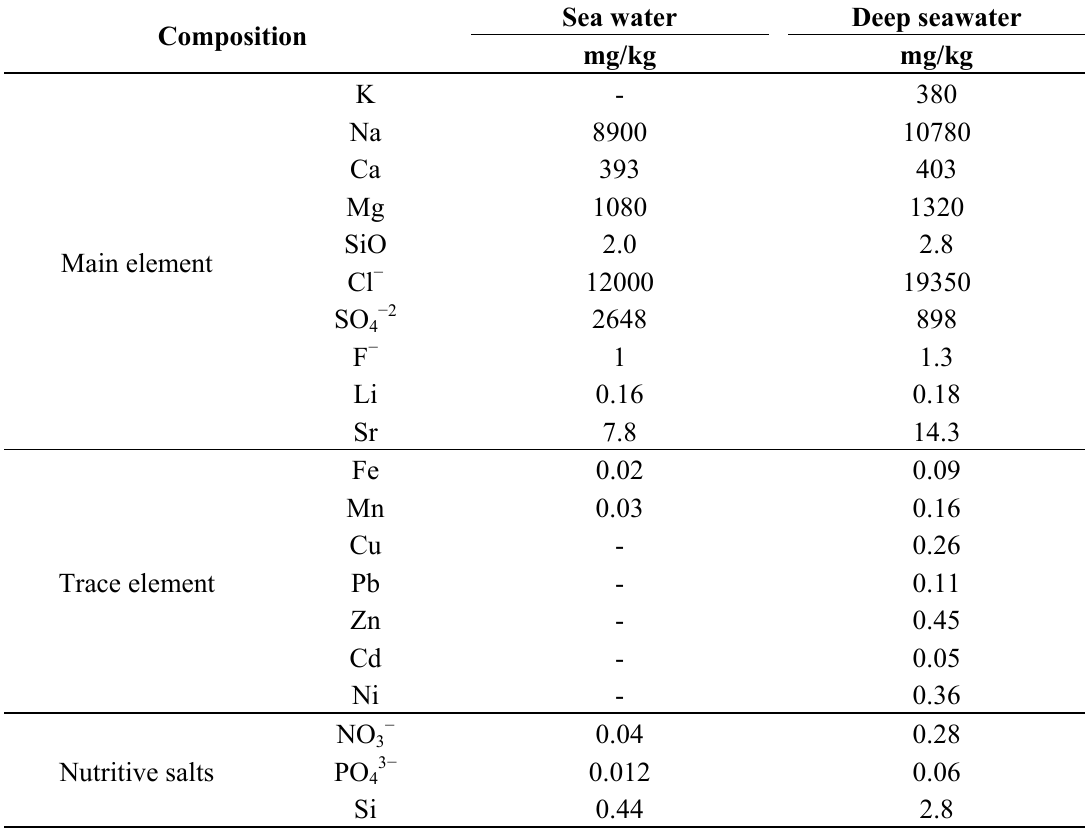
Table 3. Comparison of the mineral compositions of deep-sea water and